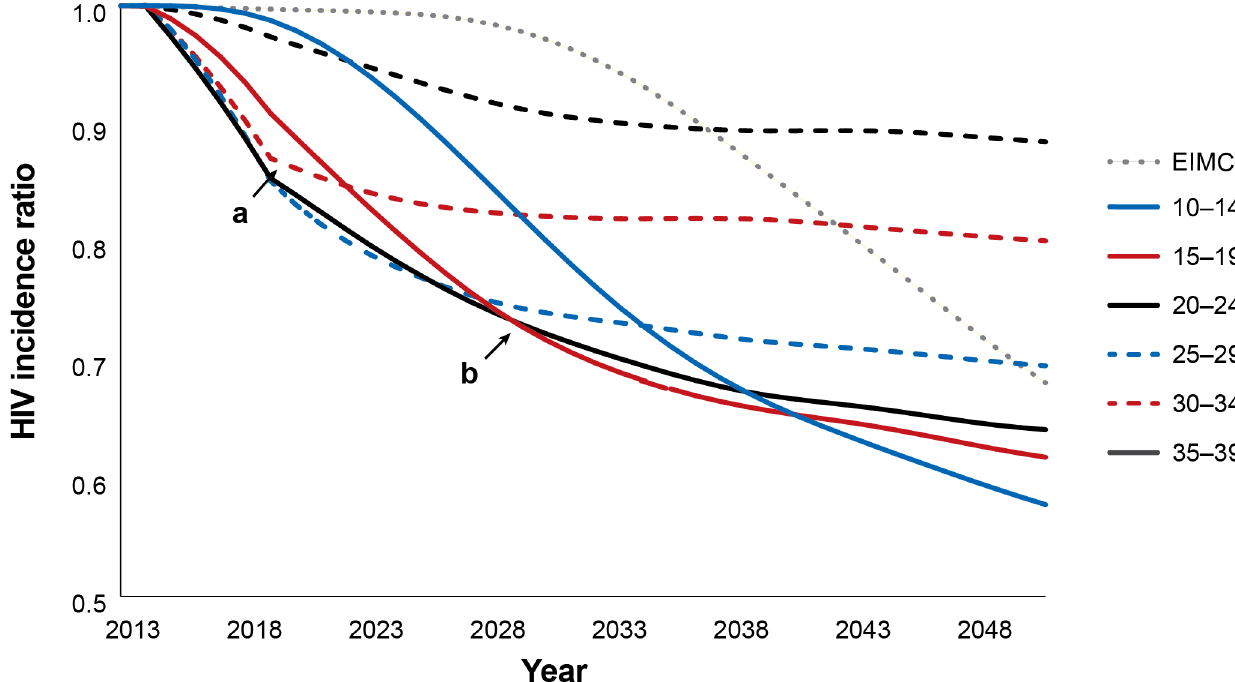
Fig 1. Reduction in HIV incidence with provision of VMMC to males, by age group, 2014 – 2050. The HIV incidence ratio represents the incidence in the scale-up scenario divided by the incidence in a population where circumcision is not scaled up over baseline levels. HIV incidence is in the entire population — males and females. Each line represents the HIV incidence ratio under a scenario in which only the indicated five-year age group is circumcised. Marker a indicates a point five years from the base year (2014). Marker b indicates a point 15 years from the base year.